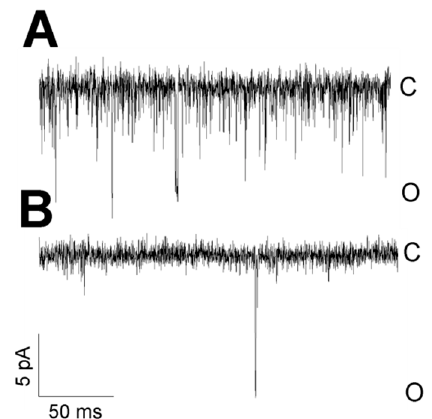
Figure 11. The flickering mode depends on cytosolic Ca 2+ . ( A ) High-frequency flickering was observed in cells treated with thapsigargin in the cell-attached configuration. Thapsigargin enhances the concentration of cytosolic Ca 2+ , and 1.7 mM Ca 2+ was present in the bath solution. ( B ) TREK-2-like channels in cells treated with BAPTA-AM had no flickering kinetics in the cell-attached configuration. BAPTA-AM removes Ca 2+ from the cytoplasm, and 0.1 mM Ca 2+ was present in the bath solution. Both traces were recorded at − 50 mV.